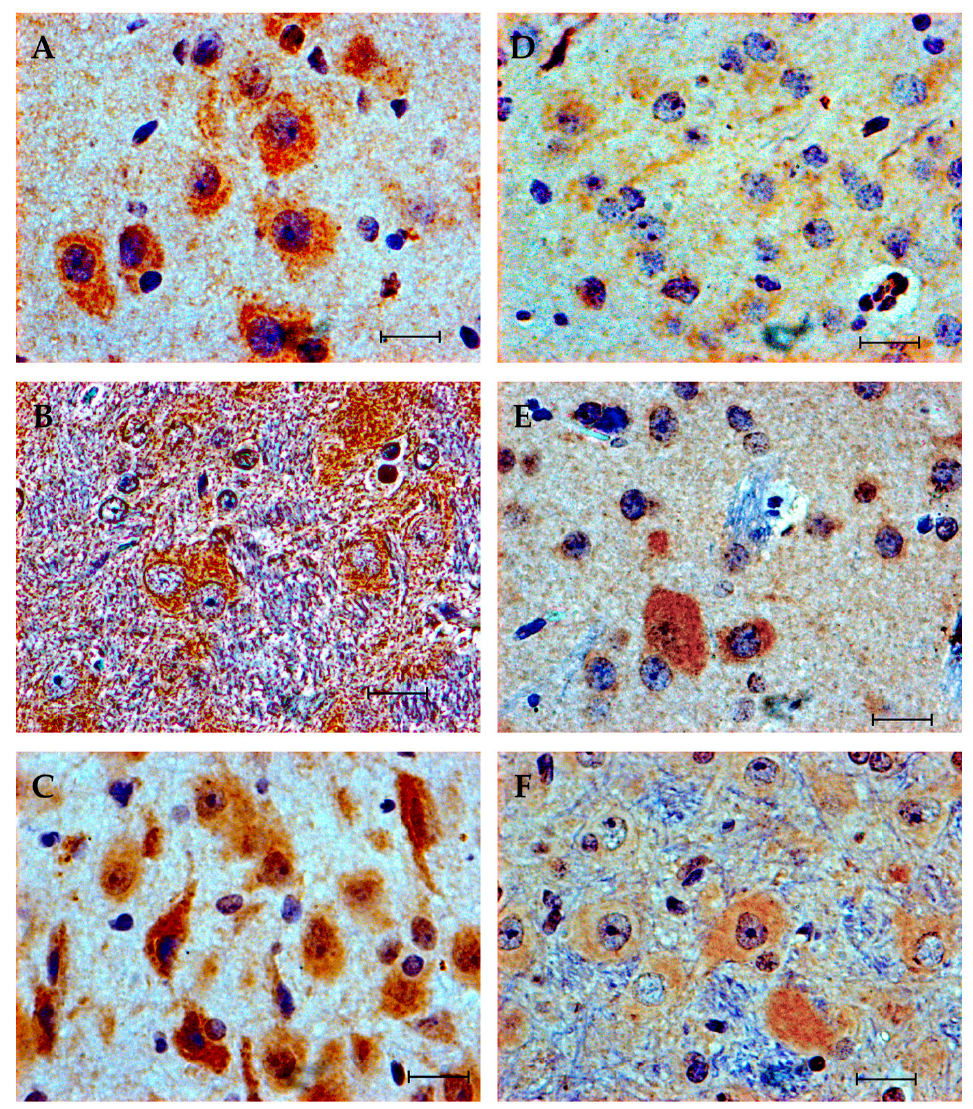
Figure 5. Cxcl16 expression in the hippocampus ( A , D ), striatum ( B , E ) and periaqueductal gray substance ( C , F ). ISO group ( A – C ). EtOH group ( D – F ). ( A – D ) in the dorsal hippocampus, moderate intensity expression is observed in the soma of pyramidal neurons in the CA1 sector in the ISO group, while it is minimal in the same region in the EtOH group. ( B , E ) in the striatum, in the ISO group, neurons with large and polygonal somas that intensely express Cxcl16, as well as neuropile, are observed, while in the EtOH group the expression is of lesser intensity and in fewer cells. ( C , F ) periaqueductal gray substance, the intensity and number of neurons that express Cxcl16 in their soma and in dendritic projections is higher in the ISO group compared to the expression in the same region of the EtOH group. Scale bar = 20 µ